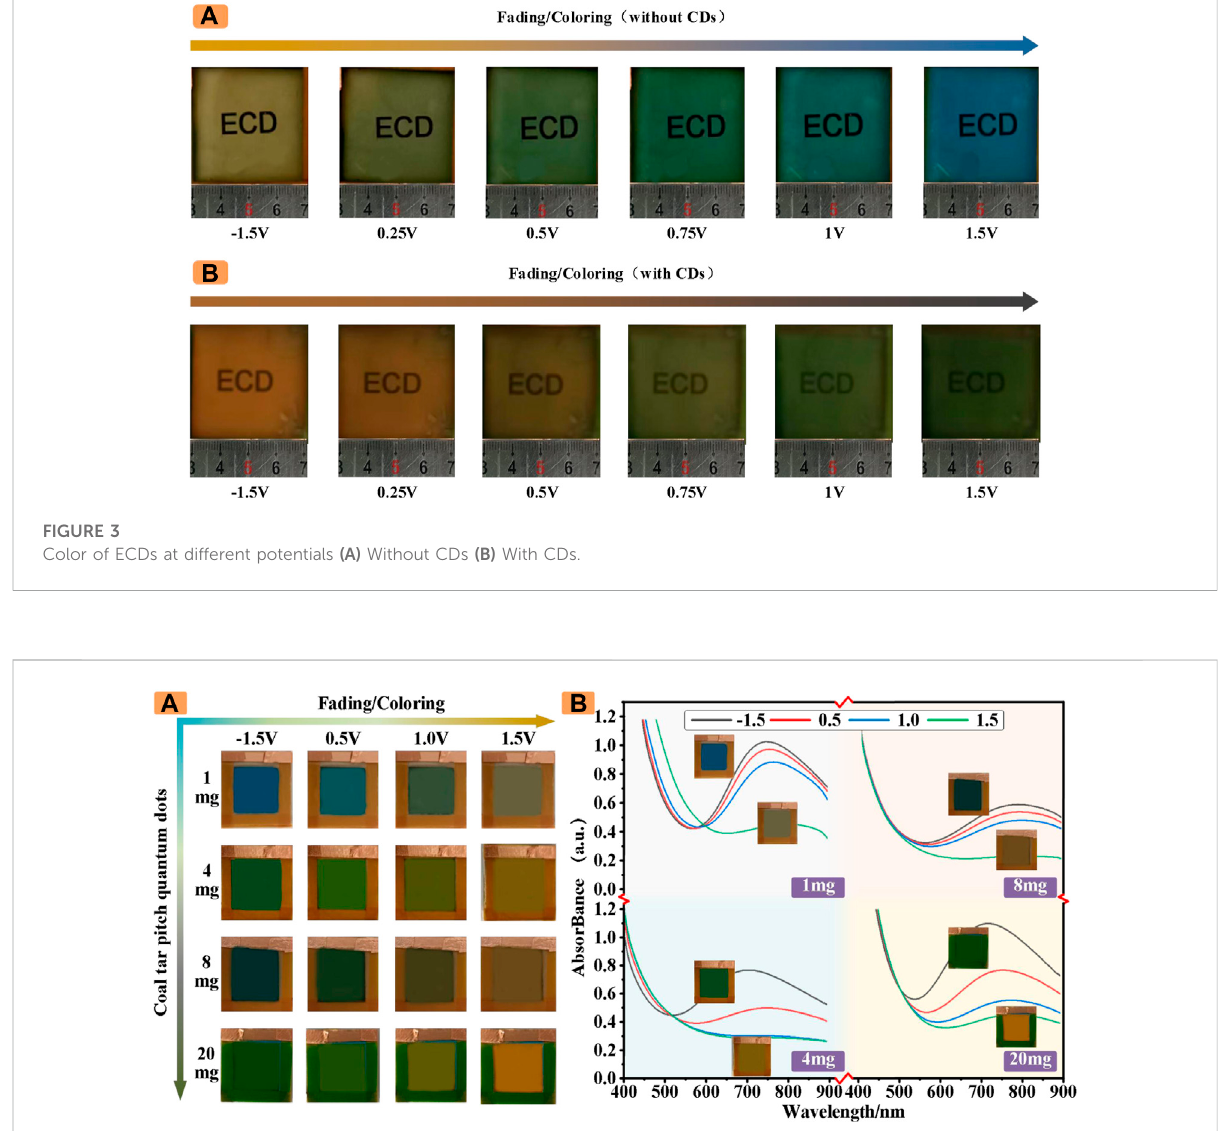
FIGURE 4 (A) The colors of ECDs with different masses of CDs at different voltages (B) The absorbance of ECDs with different masses of